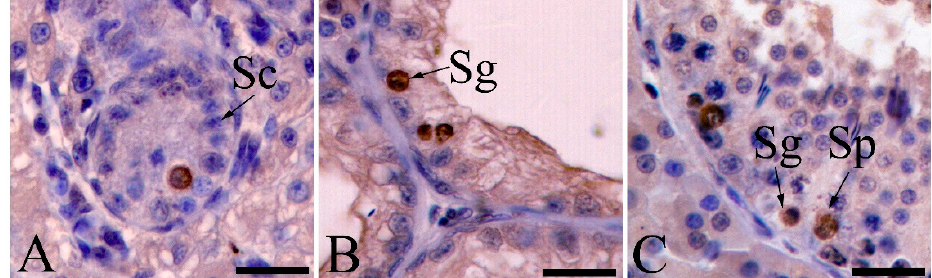
Figure 2. The number of germ and Sertoli cells in seminiferous tubules of boar testes. The number of germ and Sertoli cells ( A ) and ( B ) in preweaning, cryptorchid, and contrascrotal testes. *** p < 0.001.